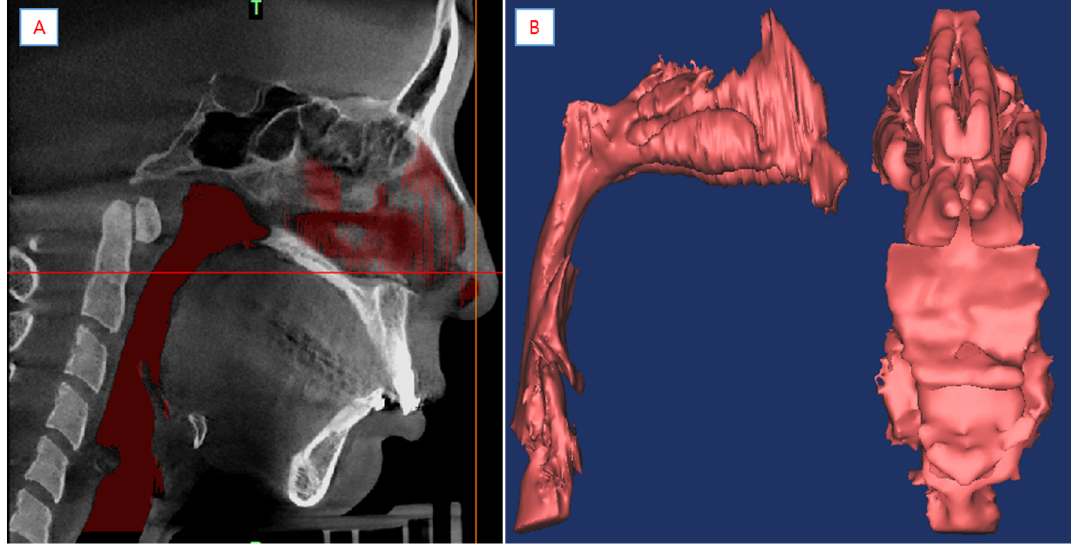
Figure 5. ( A ) Segmented pharyngeal airway. ( B ) Anatomical 3D model of pharyngeal airway was created using CBCT.